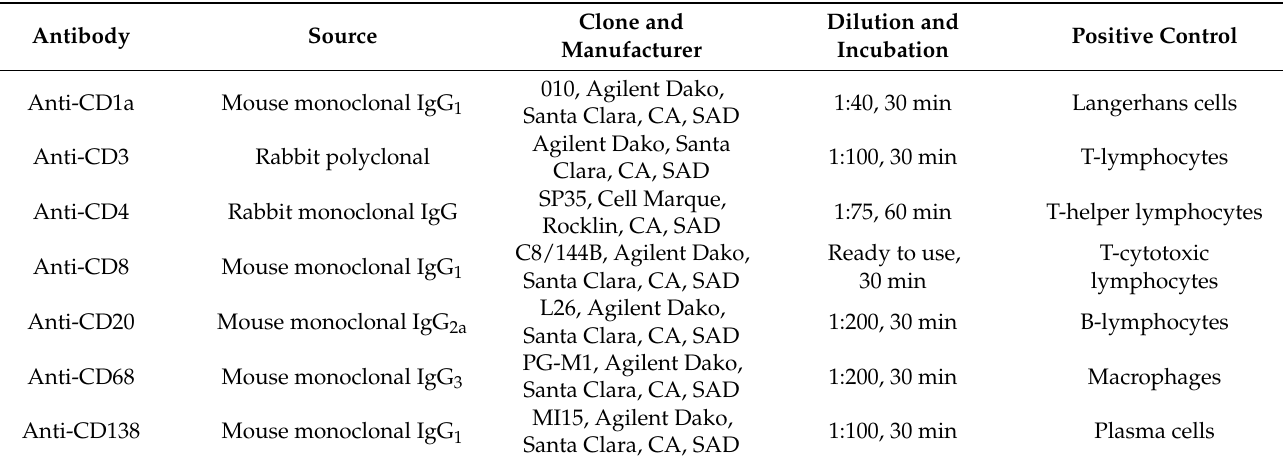
Table 1. Characteristics of primary antibodies used for